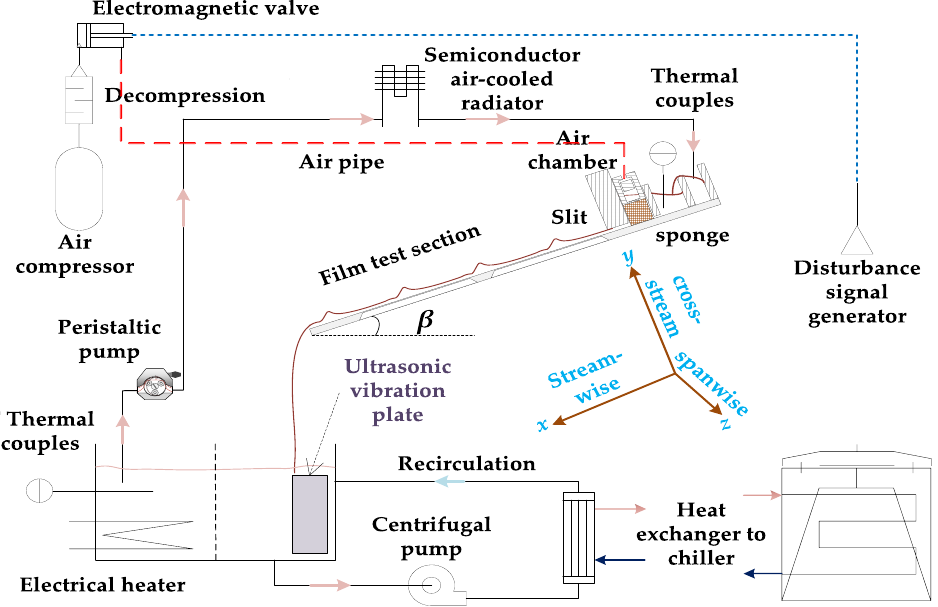
Figure 1. Schematic diagram of the experimental flow loop and film test section. The italic letters x , y , and z denote the streamwise, cross-stream, and spanwise directions of the film description coordinate system, respectively.